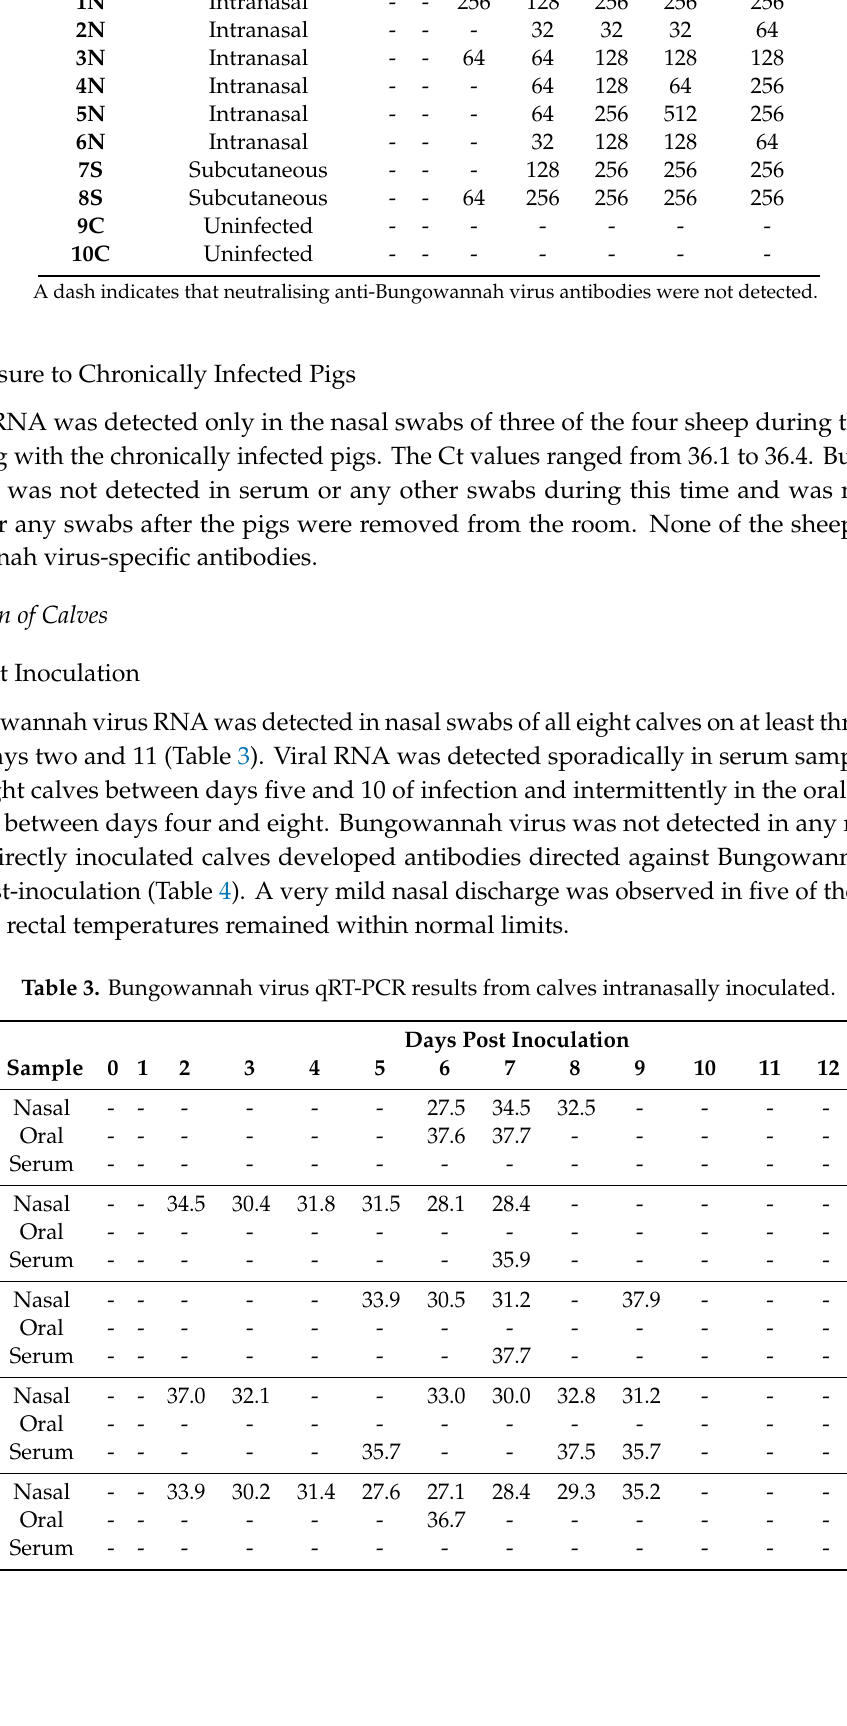
Table 2. Bungowannah VN titres from sheep intranasally and subcutaneously inoculated. Days Post Inoculation Sheep Route of Infection